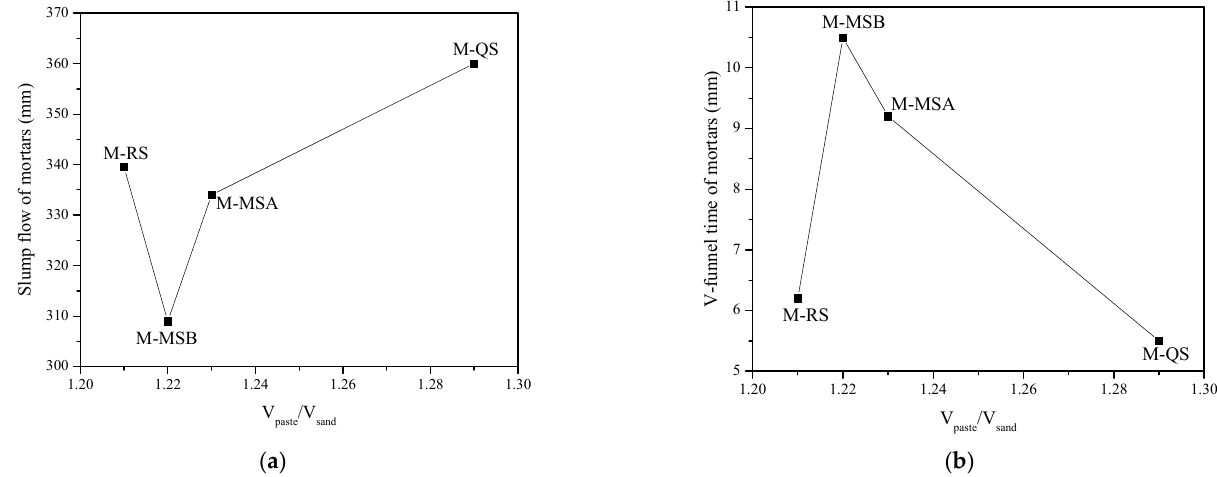
Figure 7. Relationship between rheological properties and V paste / V sand : ( a ) V-funnel times vs. V paste / V sand ; ( b ) slump flows vs. V paste / V sand .